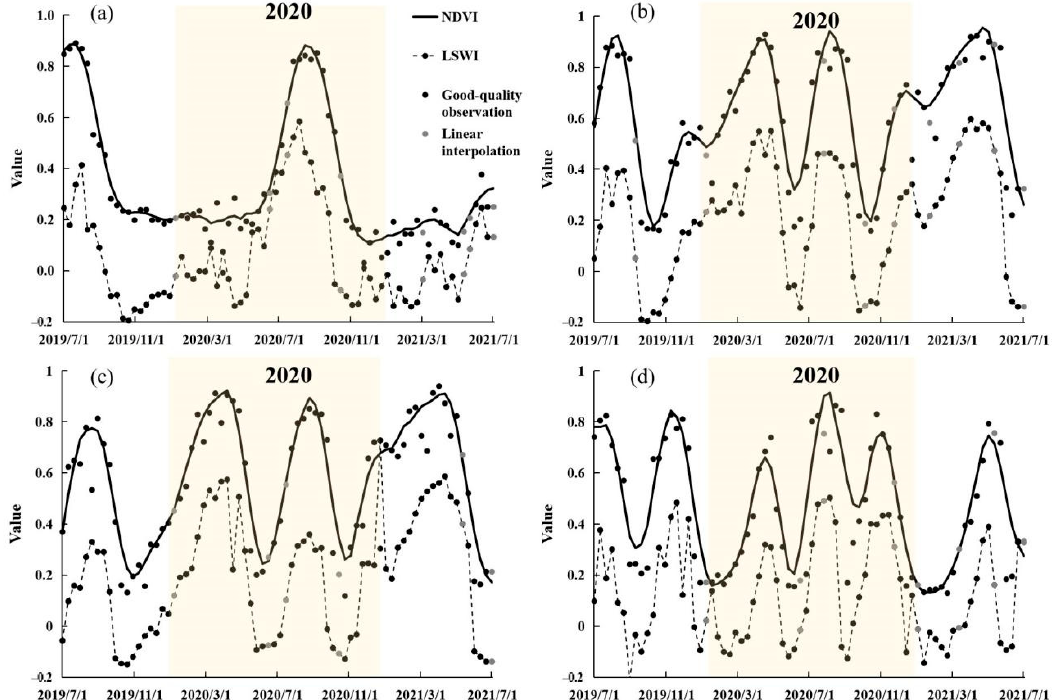
Figure 5. Temporal profile of NDVI and LSWI indices for cropping intensity sample sites with ( a ) single cropping (114.7136° E, 32.0998° N), ( b ) double cropping (115.0976° E, 34.1655° N), ( c ) double cropping (114.7069° E, 32.4664° N), and ( d ) triple cropping (115.2695° E, 33.8918° N).